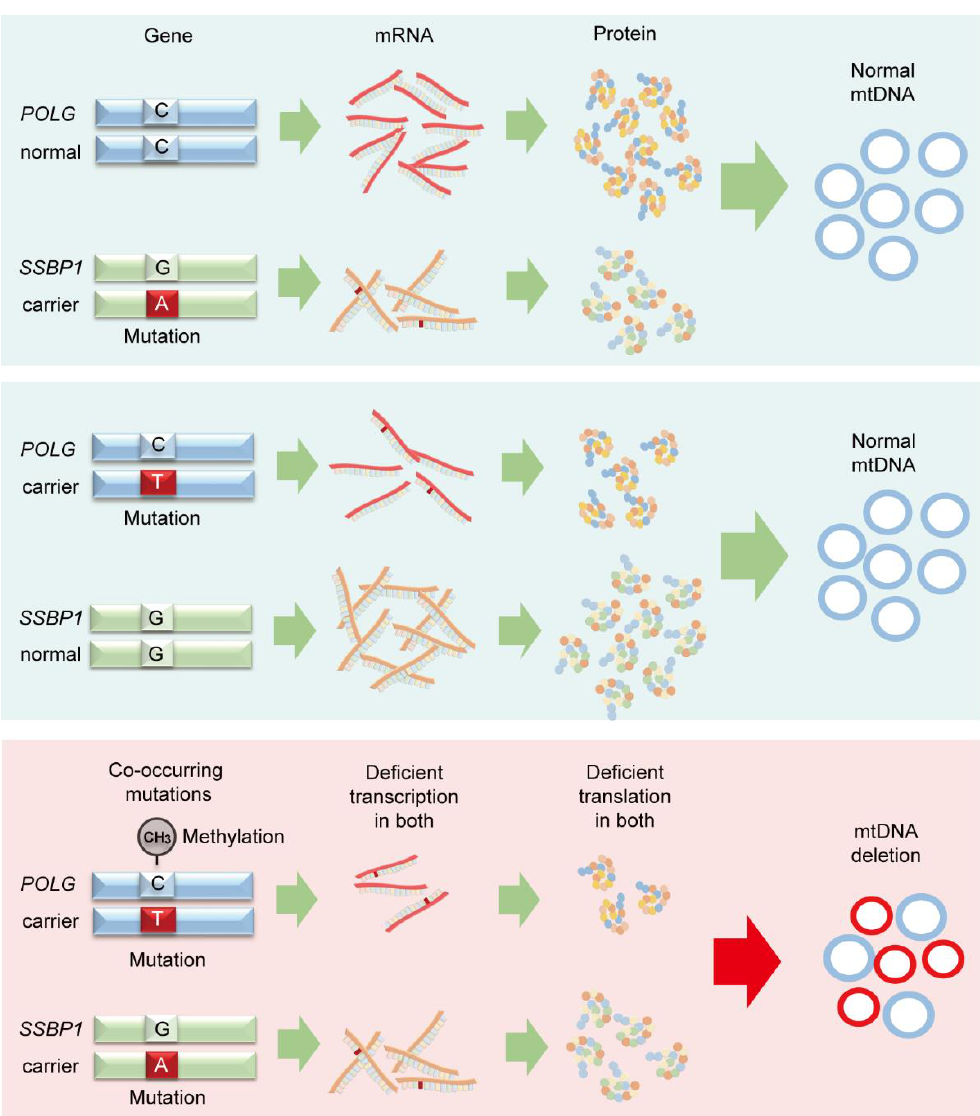
Figure 6. Schema of the penetration of mtDNA deletion and POLG and SSBP1 gene mutations. Mutations in POLG and SSBP1 genes could reduce their expression; however, they did not cause mtDNA deletion independently. Only co-deficient expression of POLG and SSBP1 could induce a large mtDNA deletion. Further, the hypermethylation mutation site could be another critical factor for the penetrance of the mtDNA defect.